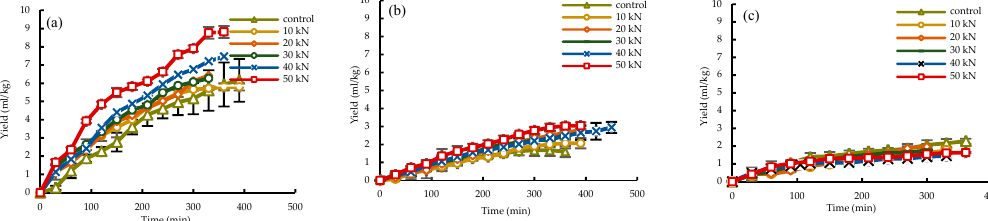
Figure 2. The yield of EOs extracted from untreated, shredded, ground, and densified (pellets and bundles) (50 kN) residual forest biomass: ( a ) balsam fir (BF), ( b ) black spruce (BS), and ( c ) jack pine (JP) by hydrodistillation.